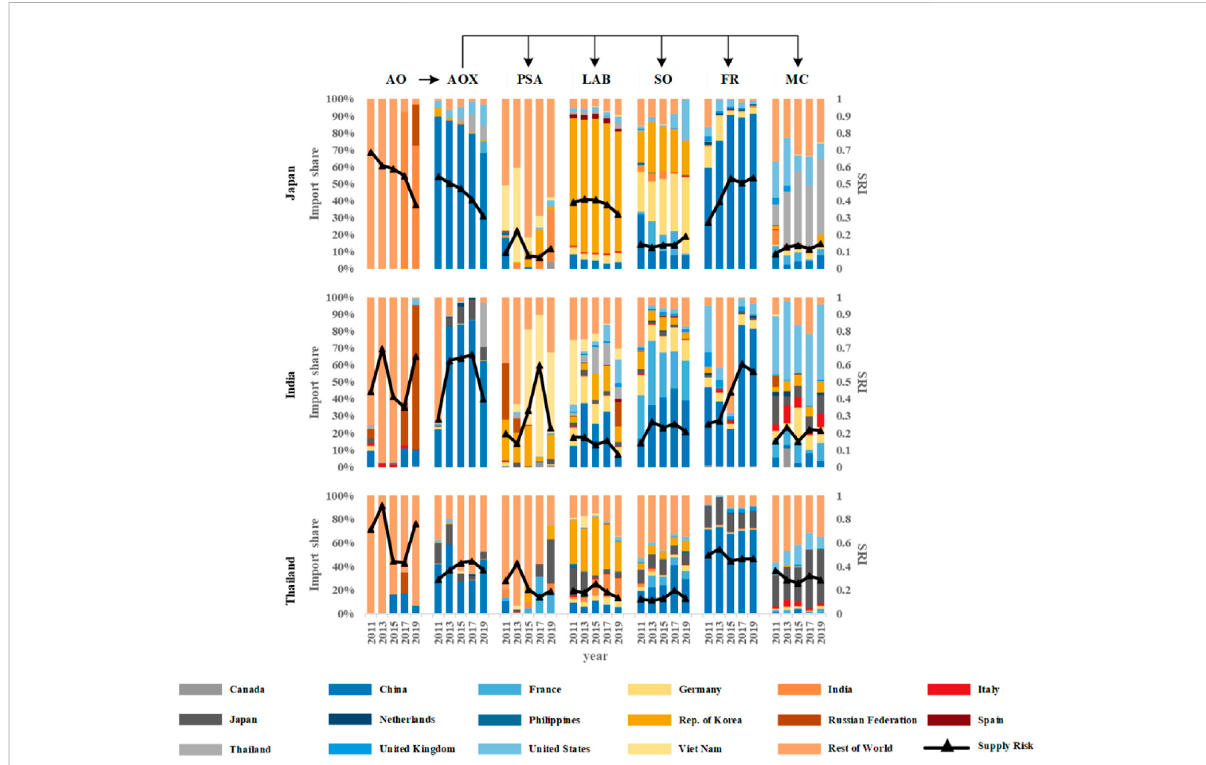
Import structures and risks of key commodities in the antimony industry chain for Japan, India, and Thailand.